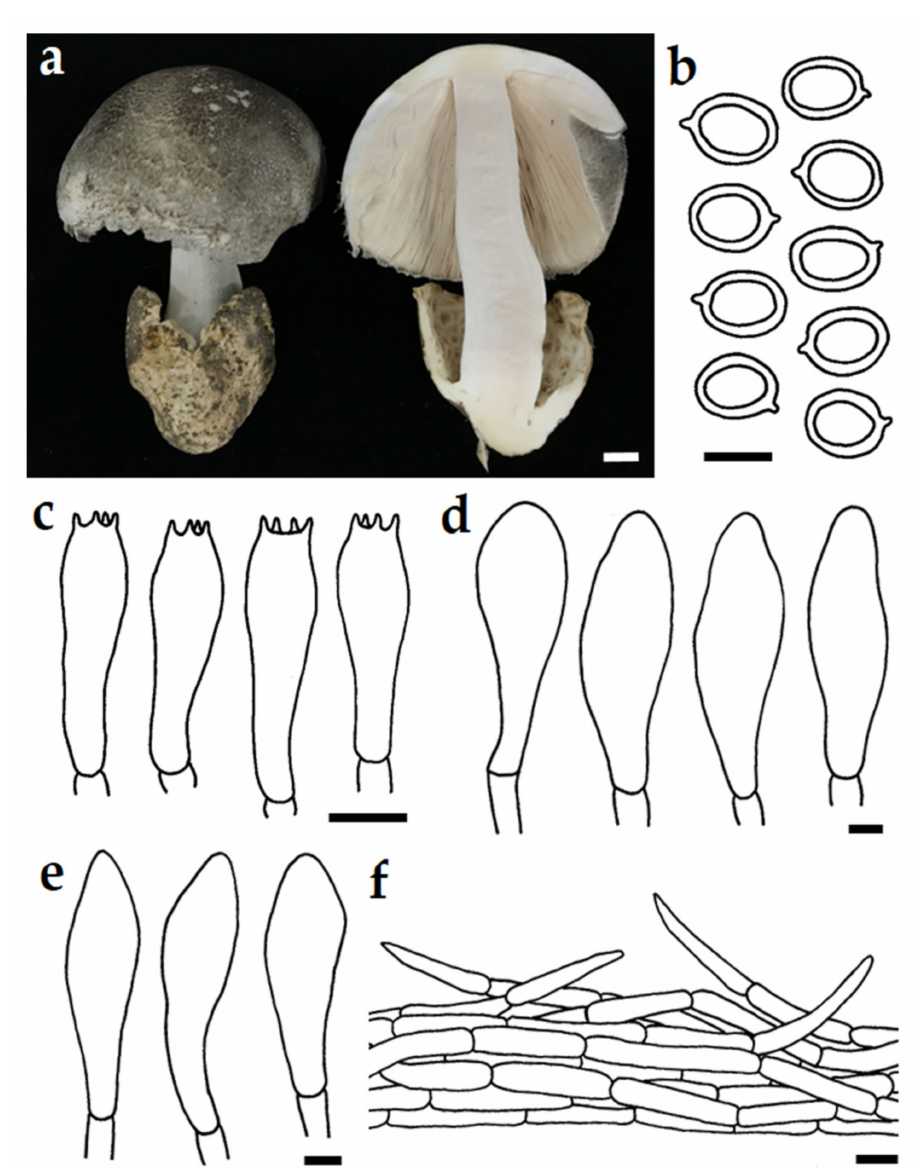
Figure 2. Volvariella neovolvacea SDBR-CMUNK0758 (holotype). Basidiomata ( a ); Basidiospore ( b ); Basidia ( c ); Pleurocystidia ( d ); Cheilocystidia ( e ); Pileipellis terminal elements ( f ). Scale bars: ( a ) = 10 mm; ( b ) = 5 µ m; ( c – f ) = 10 µ